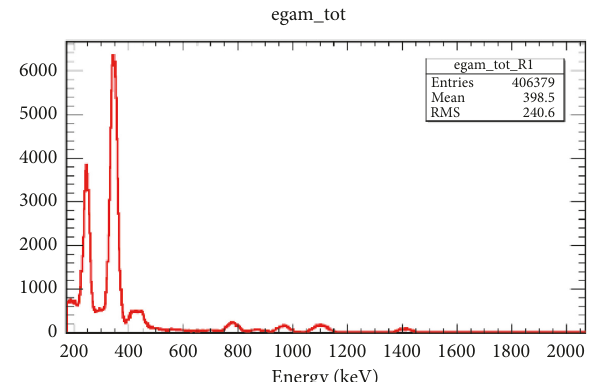
Figure 5: The simulated spectrum in using radionuclide decay shows the number of counts at different c -ray energies.